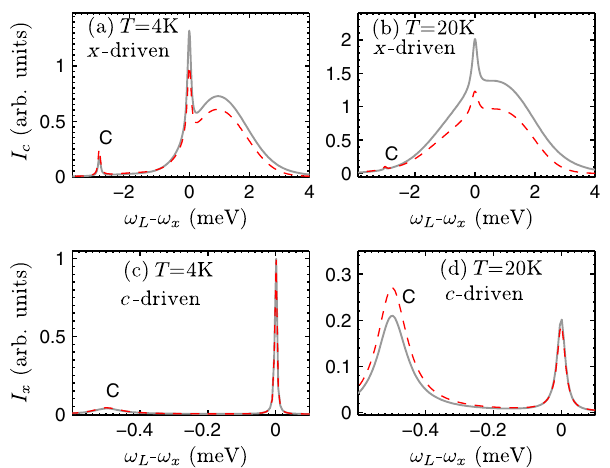
FIG. 8. (a)-(b)Cavity-modePLintensityforaQD-drivensystem ¼ 30 (cid:8) eV ) as a function of QD-laser detuning for a one- ( (cid:4) x phonon theory (red dashed line) and the full polaron model (grey ¼ (cid:1) 3 meV , for phonon-bath temperatures solid line) with (cid:1) cx (a) T ¼ 4K and (b) T ¼ 20K . (c)-(d) Relative QD (exciton) inten- ¼ 30 (cid:8) eV ) as a function of sity for a cavity-driven system ( (cid:4) c QD-laser detuning for a one-phonon theory (red dashed line) and ¼ (cid:1) 0 : 5 meV , for the full polaron model (grey solid line) with (cid:1) cx phonon-bath temperatures (c) T ¼ 4 K and (d) T ¼ 20 K